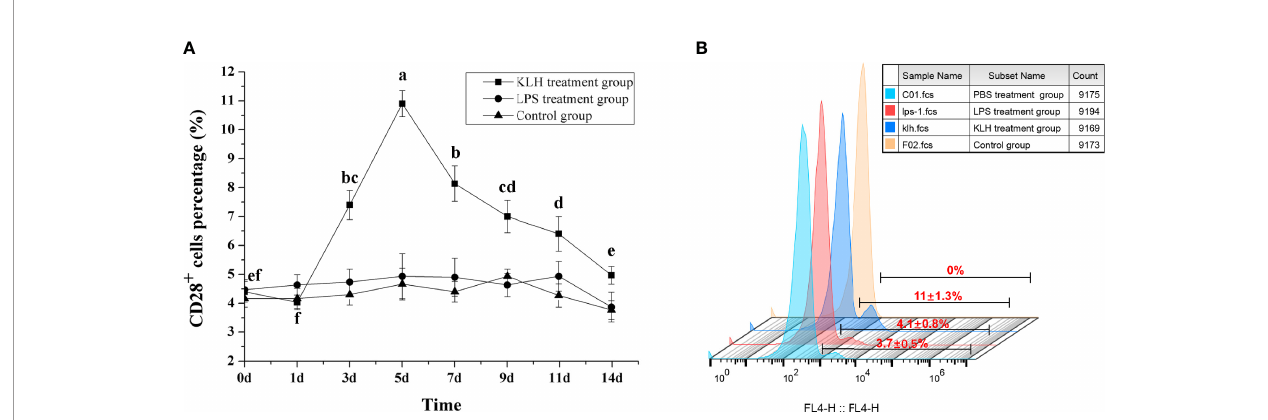
FIGURE 6 | Percentages of CD28 + leukocytes in peripheral blood of fl ounder after injected with LPS or KLH determined by fl ow cytometry. (A) Variations of percentages of CD28 + leukocytes. Letters on the bar represent the statistically signi fi cant difference, p < 0.05, data are representative of nine individuals. (B) The fl uorescent results of CD28 + leukocytes on the fi fth day.